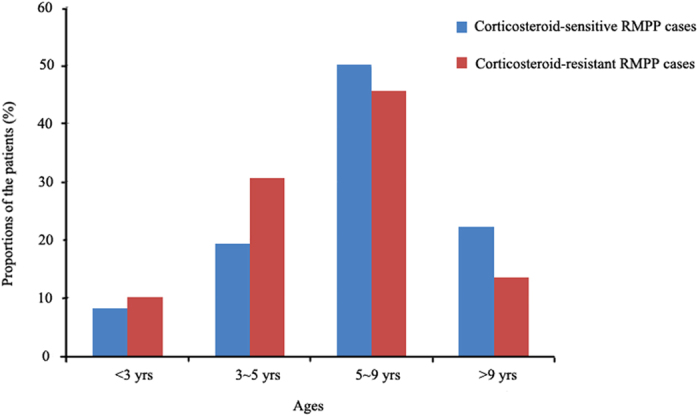
The age distribution of patients with corticosteroid-resistant and corticosteroid-sensitive refractory M. pneumoniae pneumonia.